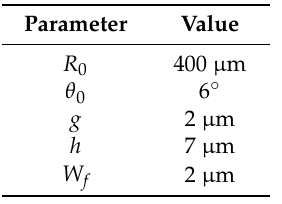
Table 1. Dimensions of the electrodes for the electrodynamic actuators of the microgripper .